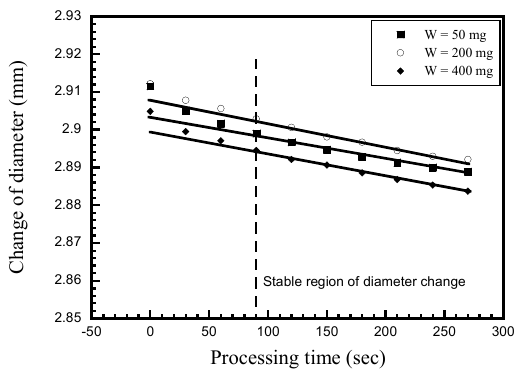
Figure 12. Variations of diameter against processing time.